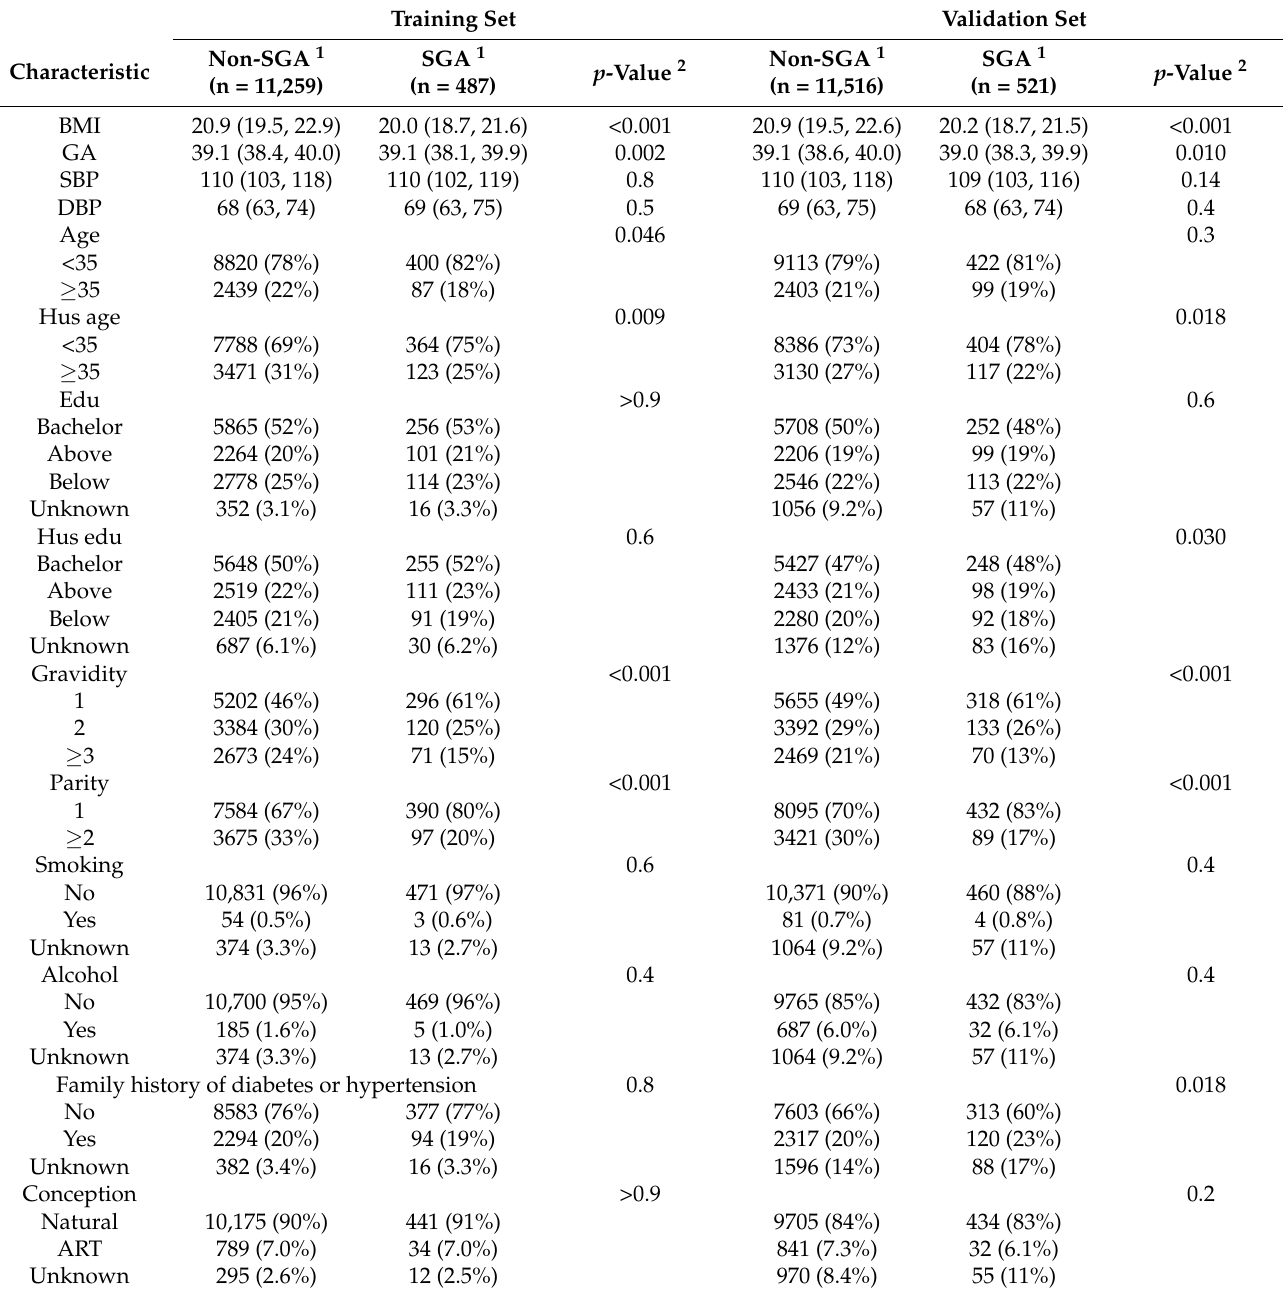
Table 1. Baseline